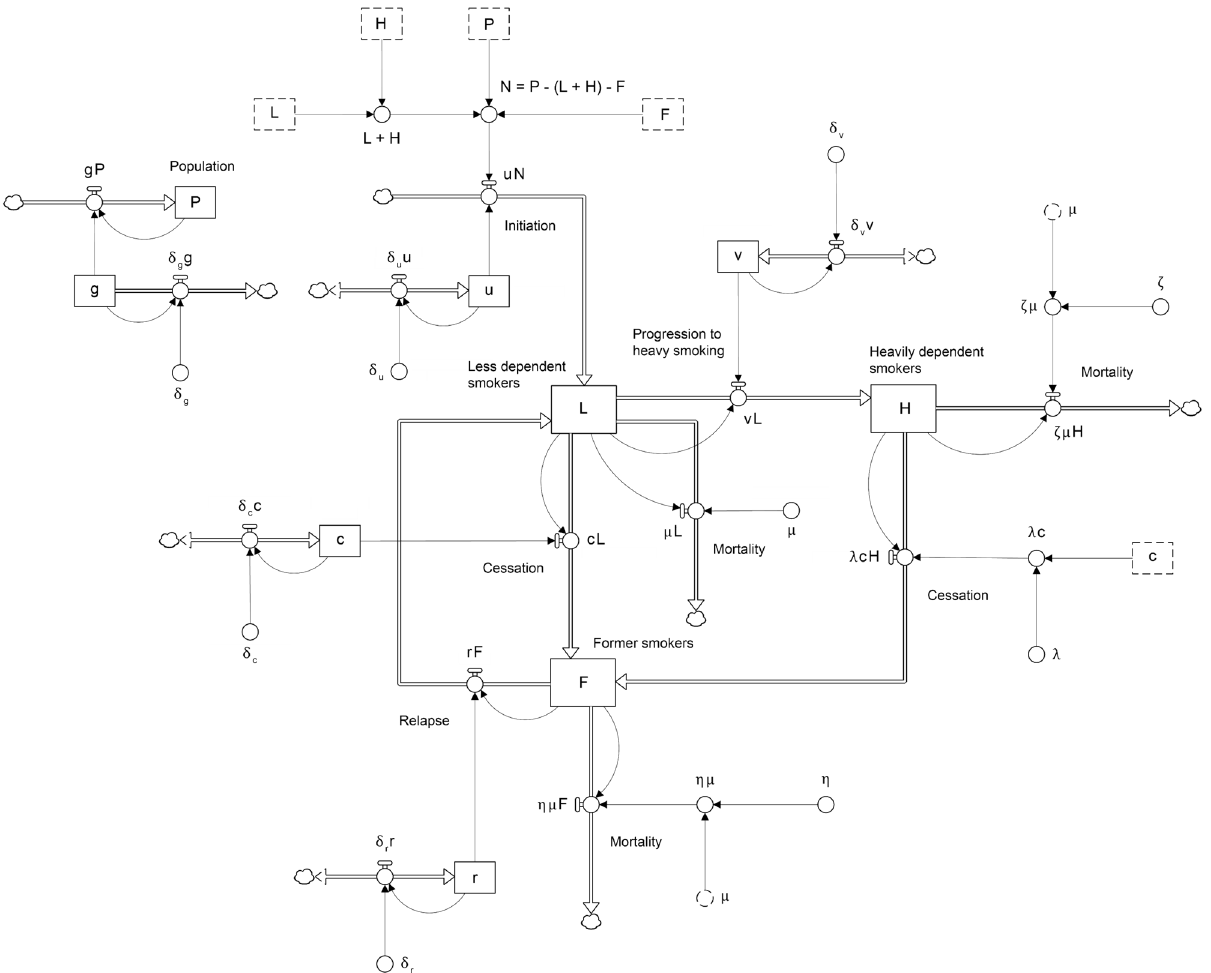
Figure 1. System dynamics model of smoking behaviour used for the simulation experiments and case study. Symbols are defined in the Methods section and Table